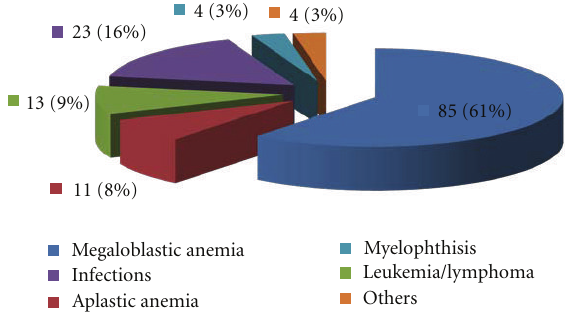
Figure 1: Clinicopathological diagnostic groups in